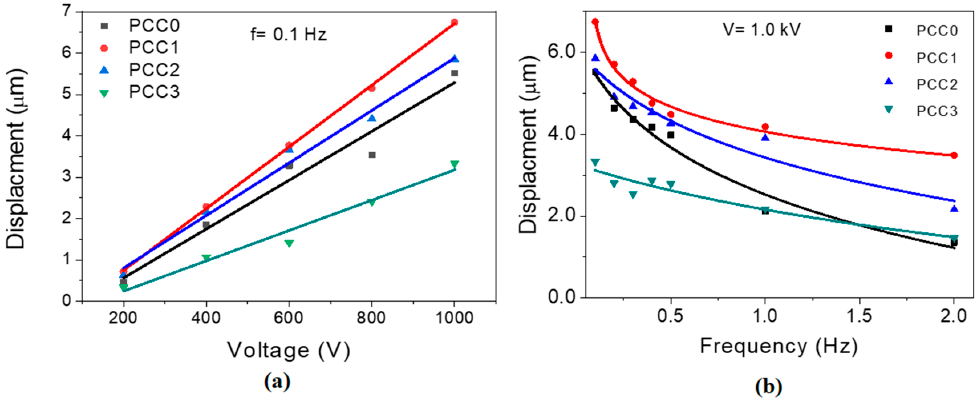
Figure 6. Actuation test results of PCC hydrogels: ( a ) voltage-dependent displacement output at 0.1 Hz and ( b ) frequency-dependent displacement output at 1.0 kV.